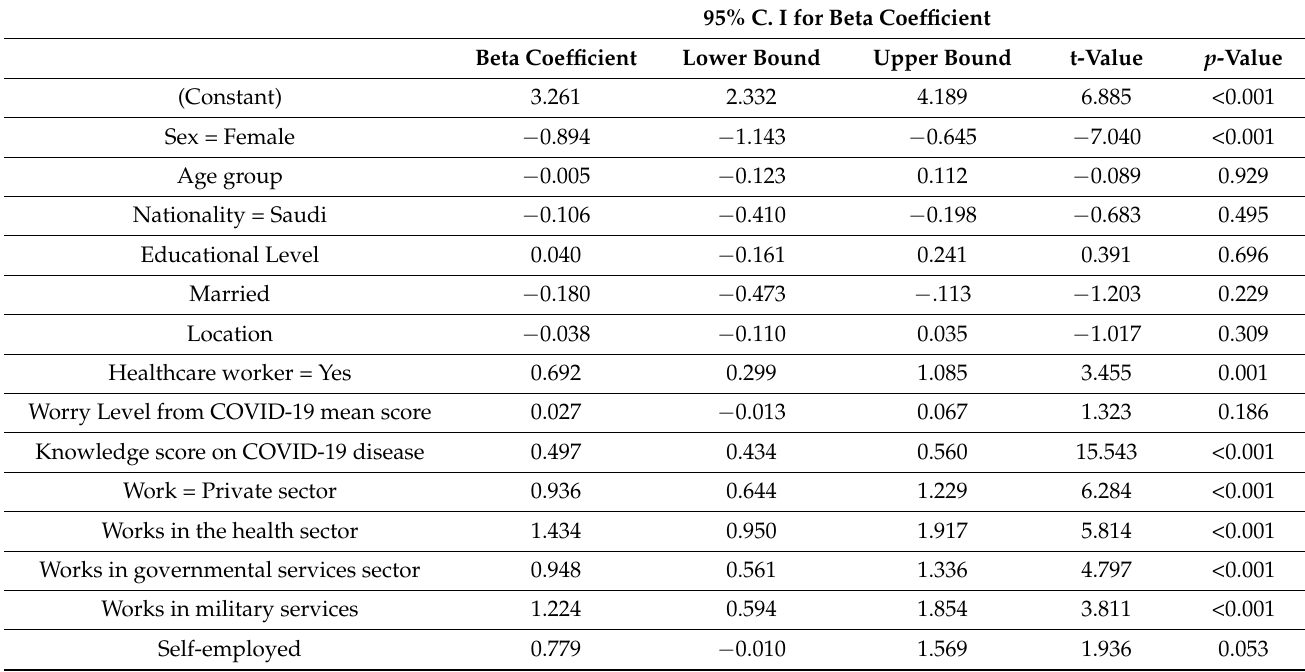
Table 4. Multivariate linear regression analysis of the patient’s hygienic practices score during the COVID-19 pandemic. n =